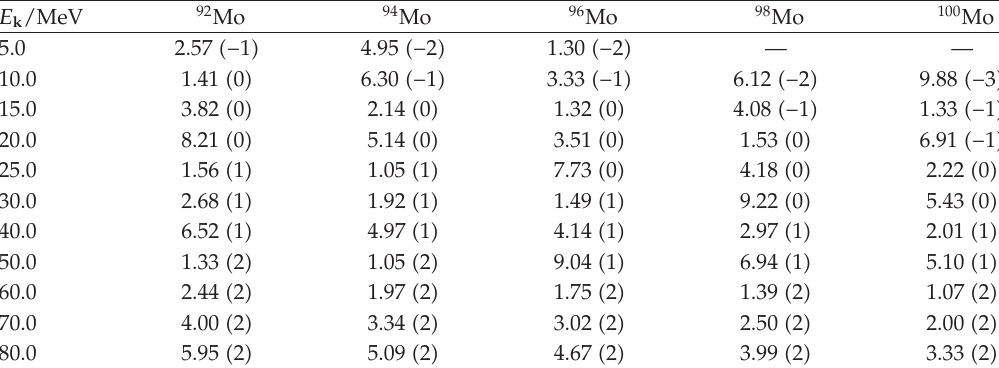
Table 2: Cross sections for the charged-current antineutrino scattering o ff the even molybdenum nuclei in units of 10 − 42 cm 2 . Exponents are shown in